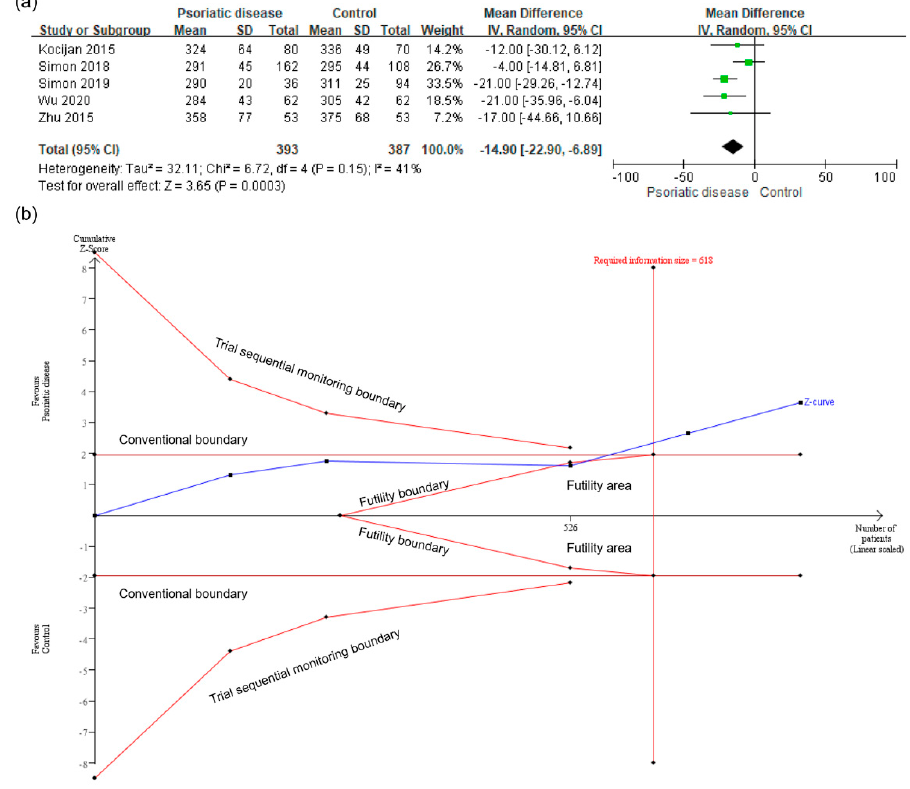
Figure 2. ( a ) meta-analysis of the mean difference in the average volumetric bone mineral density (vBMD) in psoriatic patients and controls. ( b ) trial sequential analysis of the average vBMD. CI, confidence interval; IV, inverse variance; SD, standard deviation.